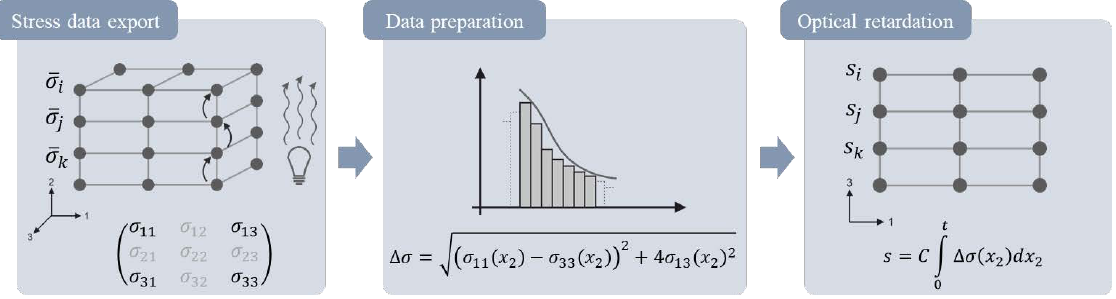
Fig. 2 Method to calculate the virtual retardation plot from FEA stress